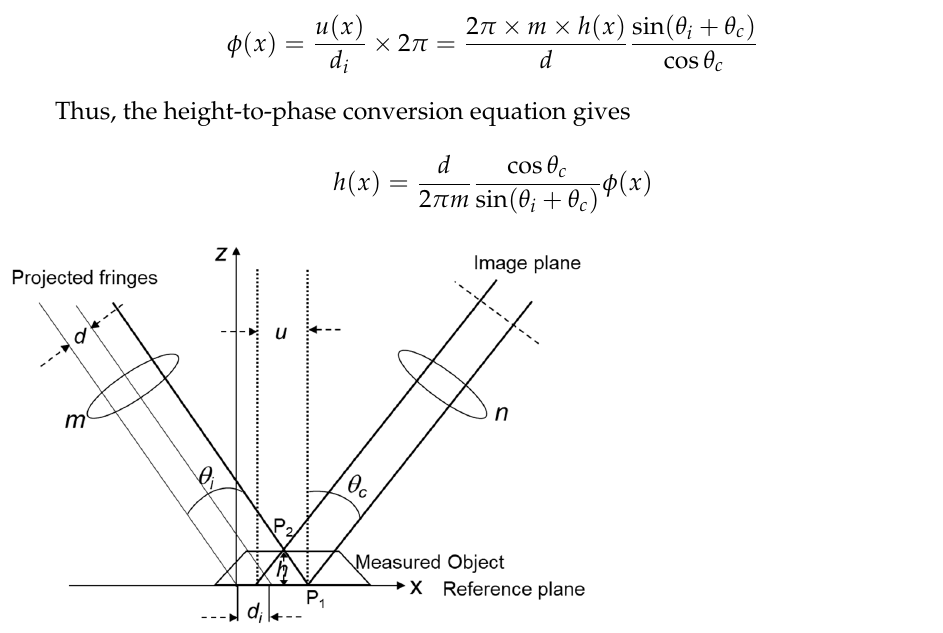
Figure 4. Schematic of the phase-height conversion based on the fringe projection method.